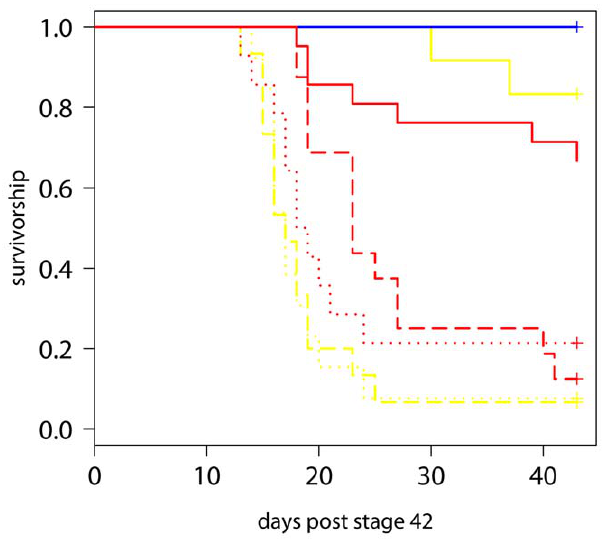
Figure 2. Survival curves for treatments and populations. Cox regression on survival depending on treatment and population. The blue line represents the Itraconazole treatment for all populations. Yellow=infected handled, red=infected unhandled. Continuous line= population BLI, dashed line=population BLZ, dotted line=population